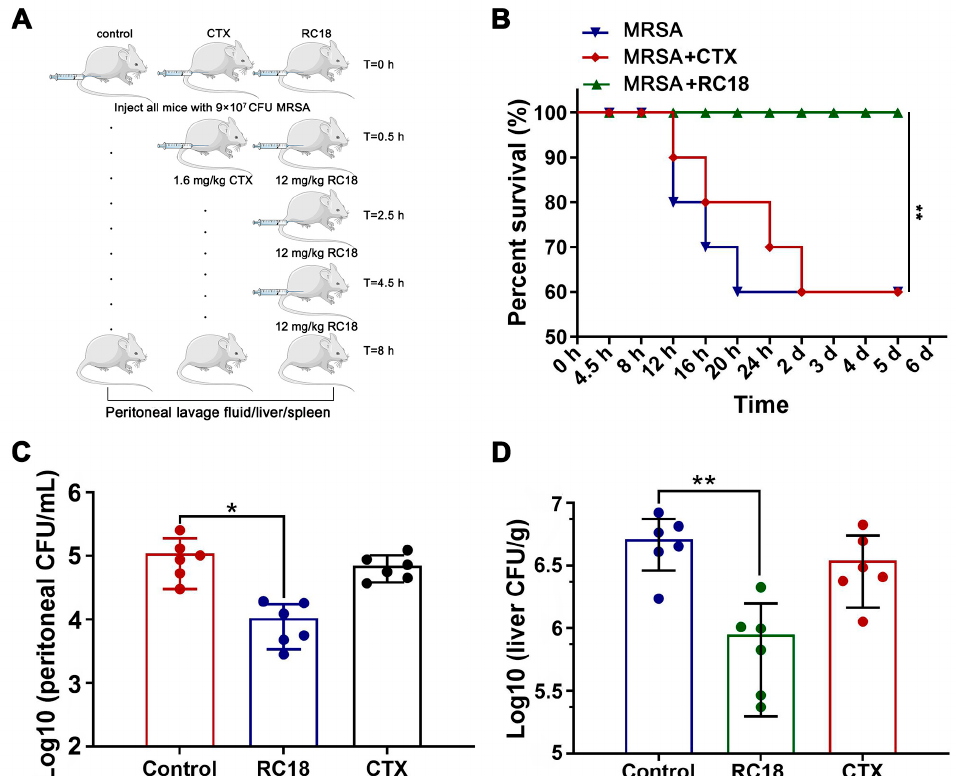
Figure 6. ( A ) Image depicting the mouse peritoneal infection experiment. ( B ) Survival curve of the infected mice after treatment with RC18 and CTX. **, P < 0.01. ( C ) Bacterial loads in mouse peritoneal lavage fluid. The results are presented as the mean ± SD. *, P < 0.05. ( D ) Bacterial colonization in mouse liver. The results are presented as the mean ± SD. **, P < 0.01.